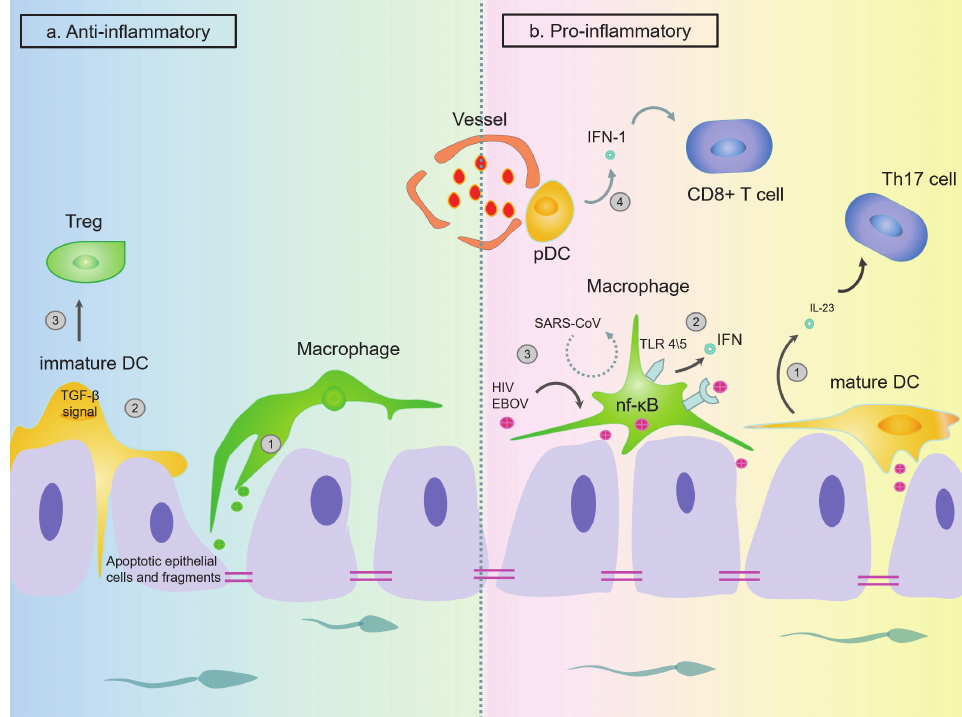
Figure 5. Physiological conditions (mainly anti ‐ inflammatory) and pathological conditions (mainly pro ‐ inflammatory) regulation of epididymal immunity. ( a ) Under physiological conditions, DCs and macrophages mainly exert immune tolerance effects. ① DCs and macrophages can phagocytose the apoptotic epithelial cells and their fragments. Together, they maintain the integrity of the blood– epididymis barrier (BEB). ② DCs can maintain the immature state through TGF ‐β signal transduc ‐ tion to maintain immune tolerance. ③ DCs can inhibit the inflammatory response by promoting